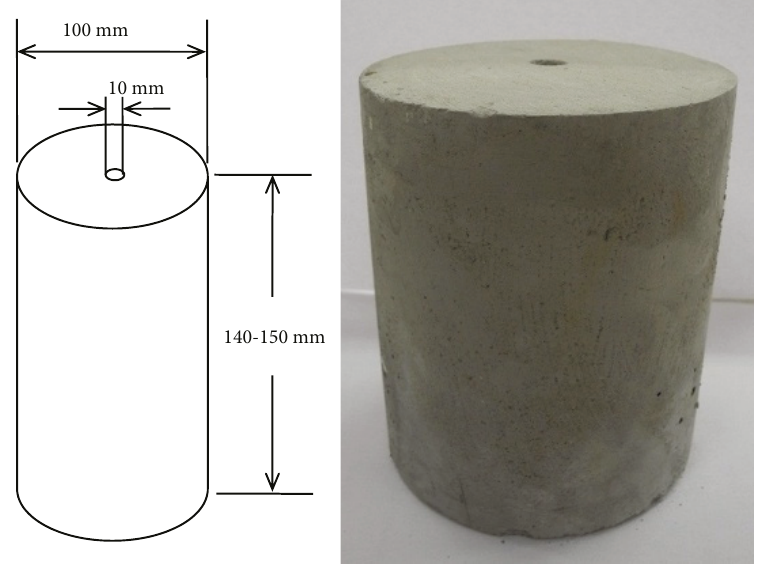
Figure 2: Schematic diagram and photograph of the core. Table 1: Porosity and permeability of the core.